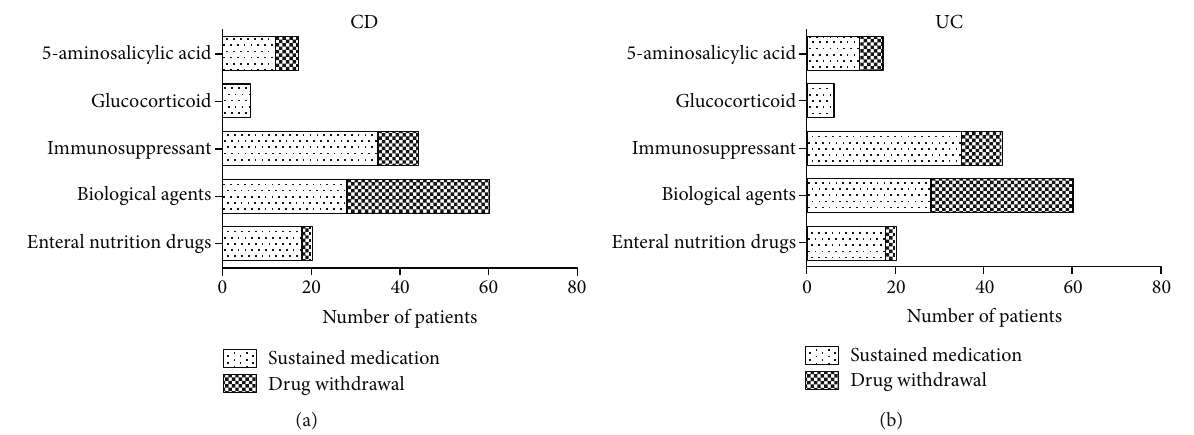
Figure 1: Continuation and discontinuation of medications in IBD patients during the COVID-19 epidemic. (a) The number of CD patients who continued and discontinued their medications (5-aminosalicylic acid, glucocorticoid, immunosuppressants, biological agents, and enteral nutrition drugs). (b) The number of UC patients who continued and discontinued their medications. Table 2: Gastrointestinal, respiratory, and systemic symptoms in IBD